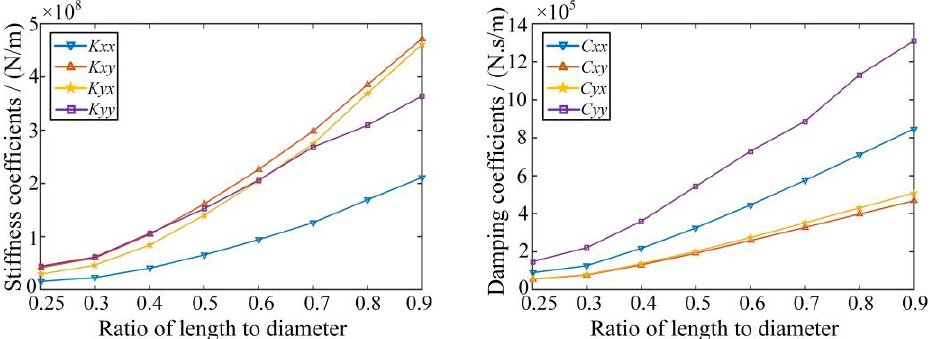
Figure 7. Variation tendencies of the dynamic coefficients for different clearance ratios φ .